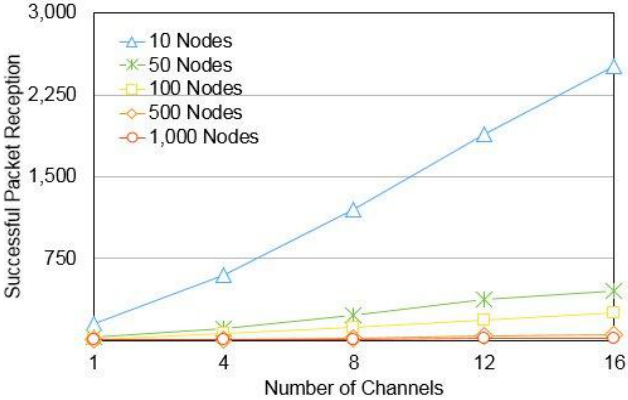
Figure 1. Shows a comparison of single and multi-channel successful packet